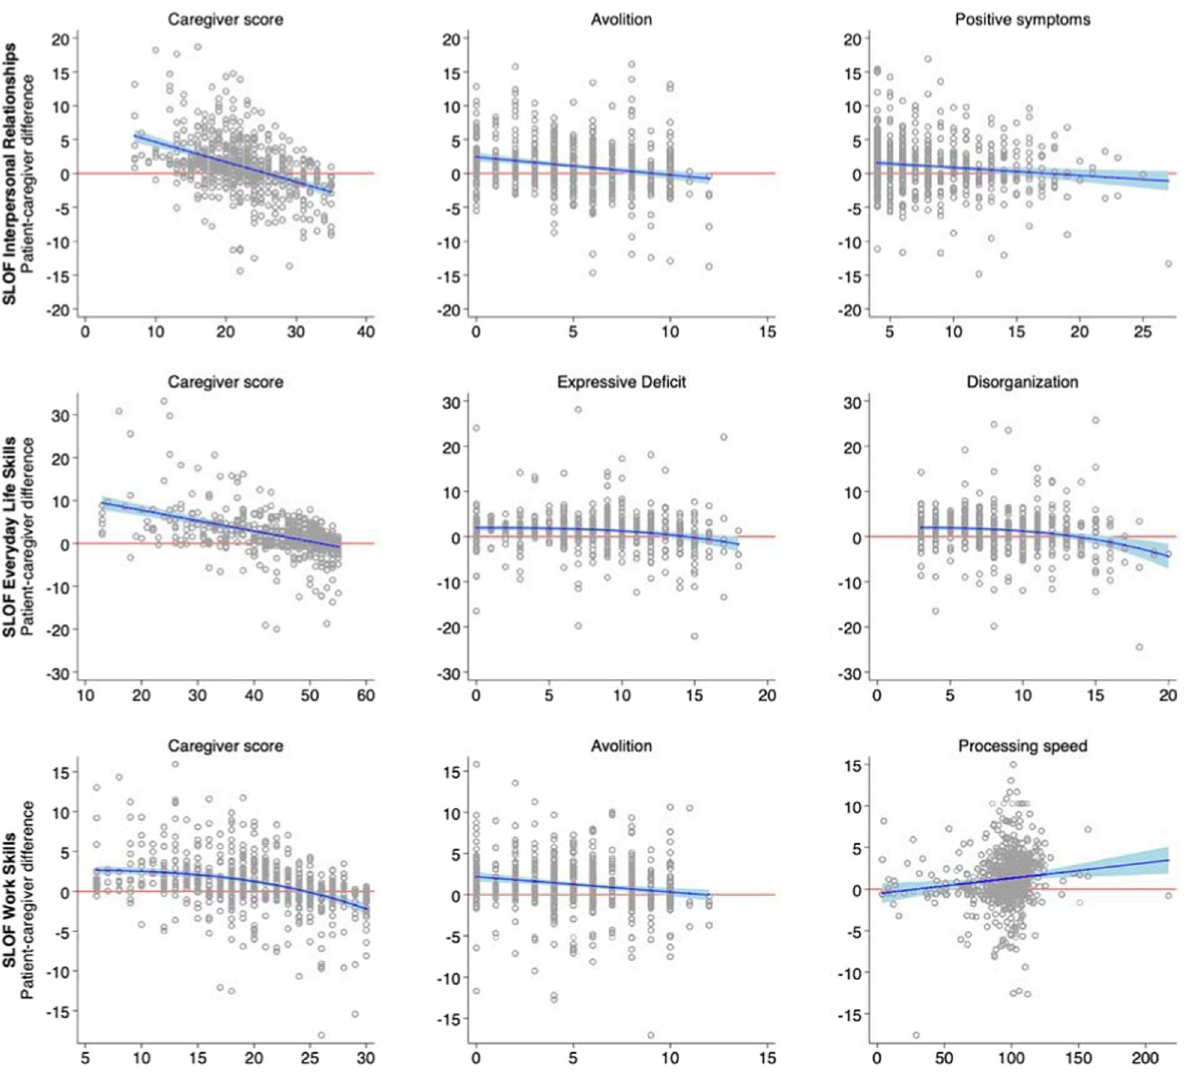
Fig. 2 Scatterplots of patient-caregiver differences in the three SLOF domains and their signi fi cant predictors, with the estimated regression curve. Note: in these plots, circles represent patients, whose coordinates are given by patient-caregiver difference ( Y axis) and values of its signi fi cant predictors according to multivariable fractional polynomial regression ( X axis). The blue line represents the estimated regression curve, with 95% con fi dence interval as shaded